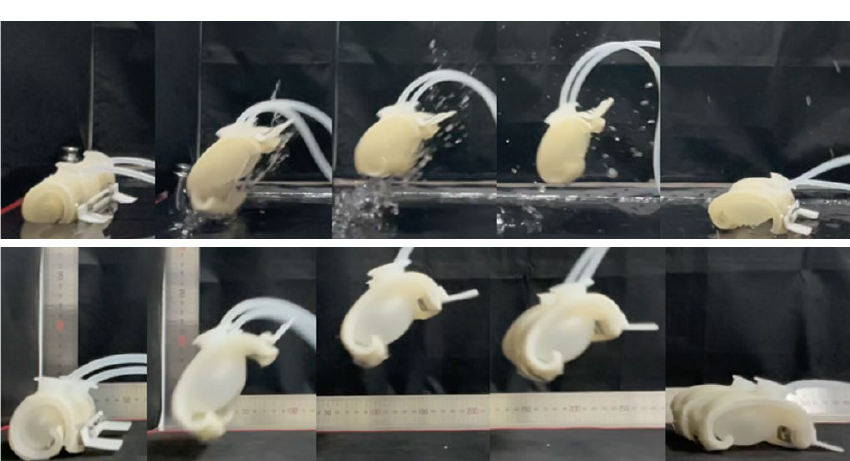
Figure 22. Comparison of the jumping motion of soft jumping robots on water pools and flat land.